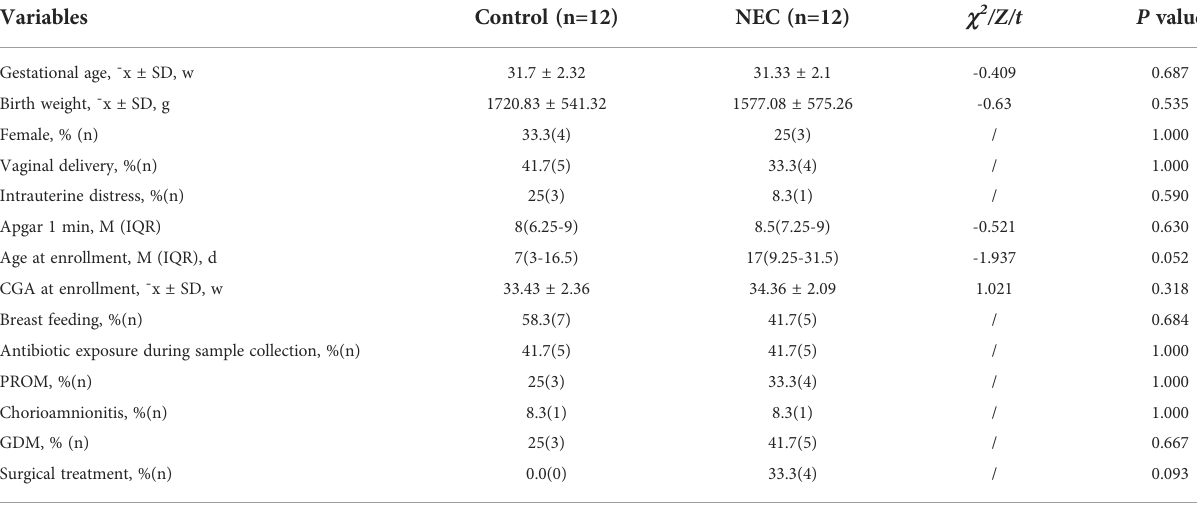
TABLE 2 Patient